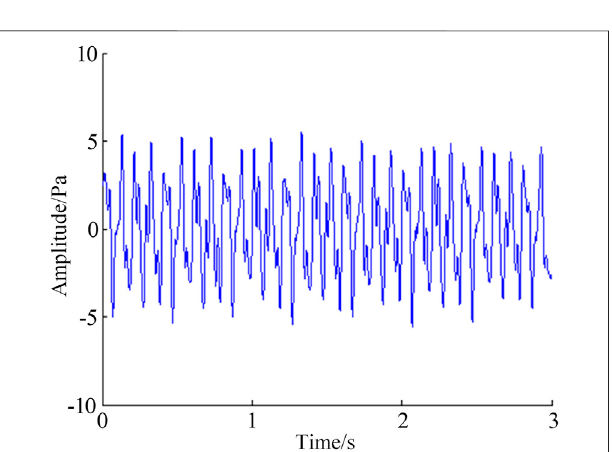
FIGURE 4 | Waveform of the noise signal.